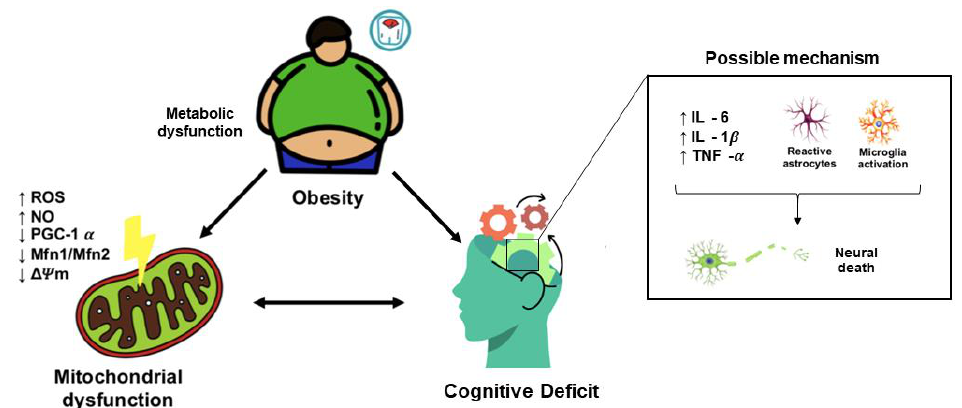
Figure 2. Obesity, neuroinflammation, and mitochondrial dysfunction. Excessive food consumption in obesity can lead to mitochondrial dysfunction characterized by increased reactive oxygen species (ROS) levels, increased nitric oxide (NO) levels, decreased protein content of PGC-1 α and Mfn1/Mfn2, and decreased mitochondrial membrane potential ( ∆Ψ m). Obesity is associated with increased levels of inflammatory cytokines in the brain and compromises neural viability.